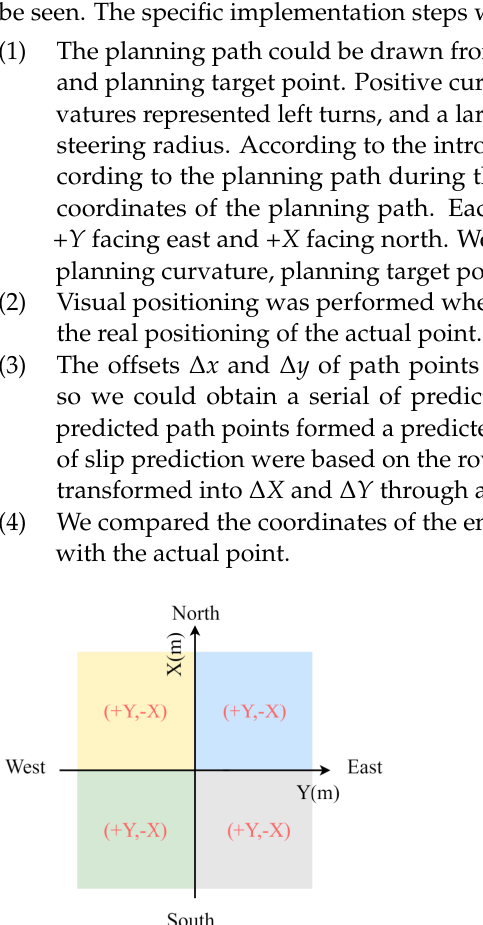
Table 5. BP and GA-BP predicted end points of path.